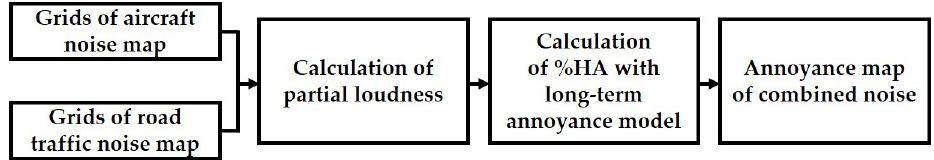
Figure 8. Annoyance mapping procedures.